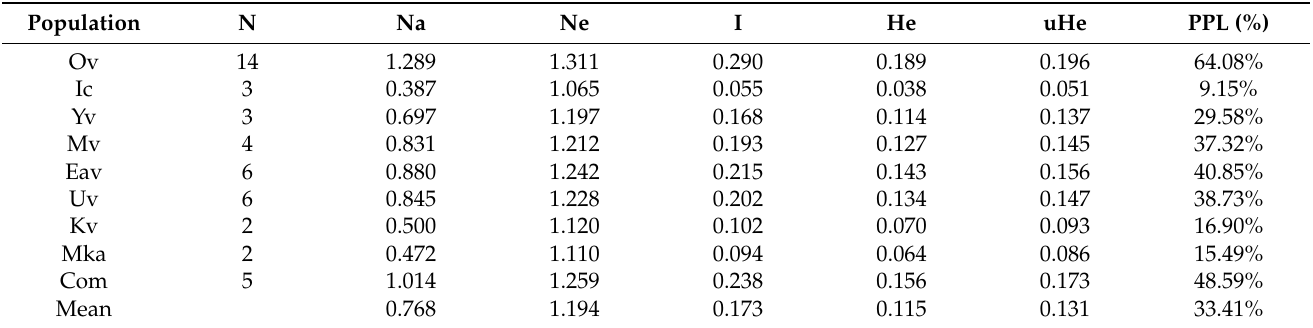
Table 7. Estimates of genetic diversity and distribution of gene diversity between the populations of P. vulgaris L. assessed with twenty-seven SSR primers.